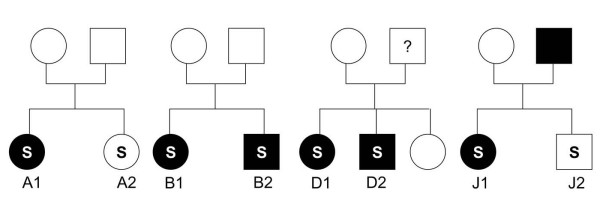
Pedigree of family and genotyping by BU678720 LOH. "S" stands for individuals with schizophrenia, the filled symbols indicate individuals with BU678720 LOH and open symbols the individuals without BU678720 LOH. The question mark indicates an individual in whom LOH analysis was not performed.